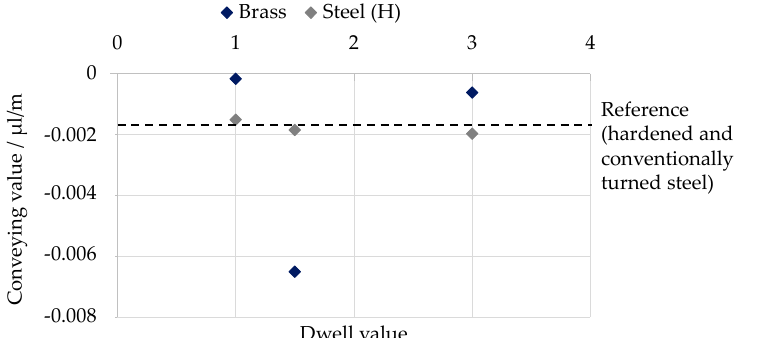
Figure 12. Relationship between dwell value and conveying value of selected hardened steel and brass specimens.